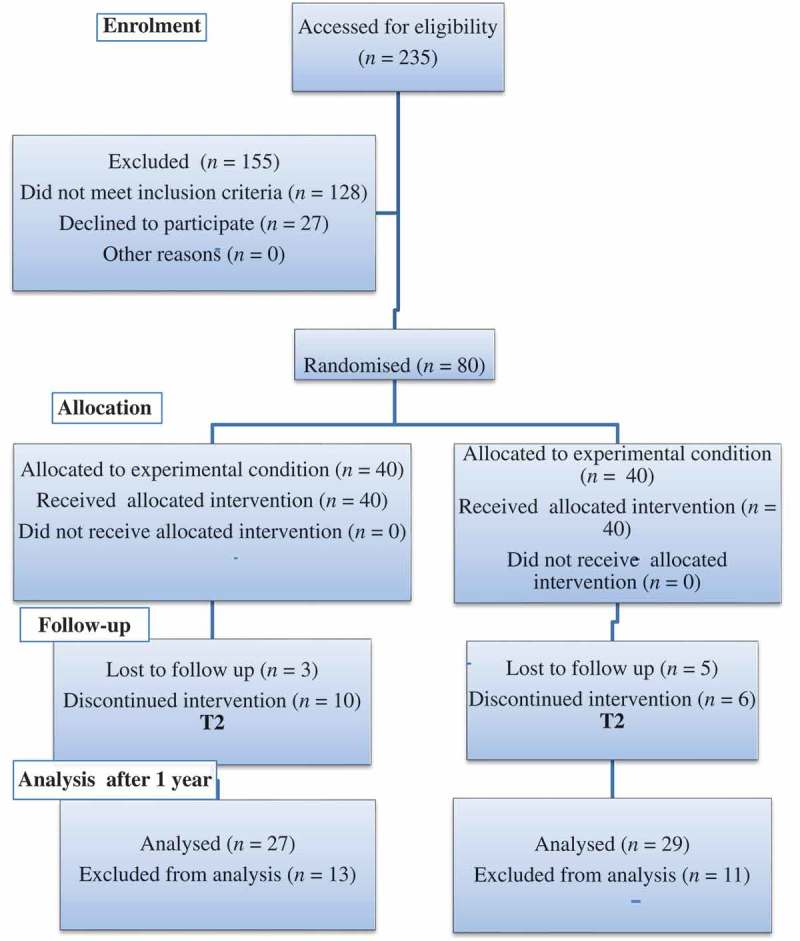
Consort flow chart.